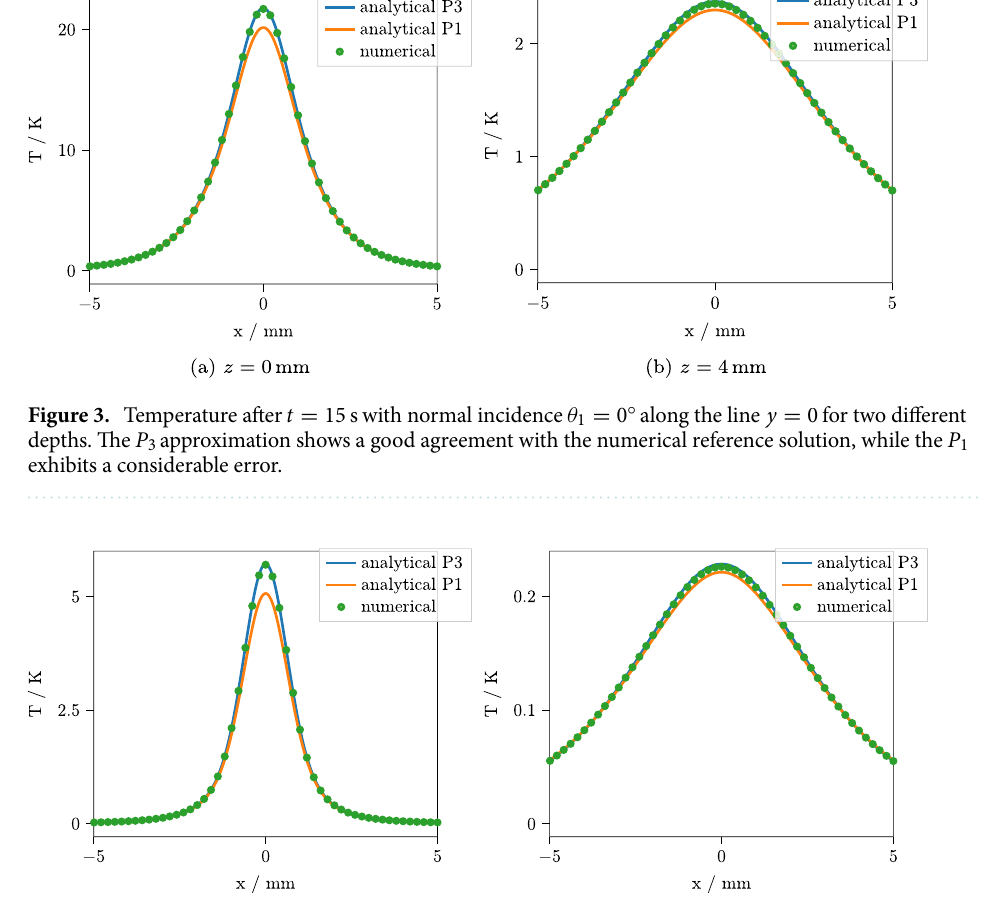
1 s with normal incidence θ 1 =